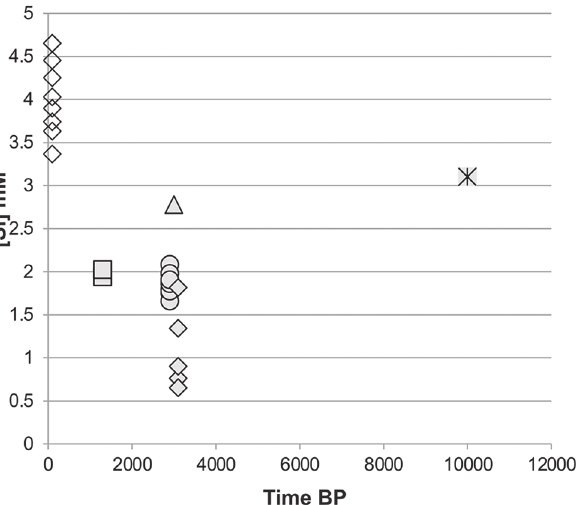
Fig 2. Comparison of solubility at pH 10 among modern and ancient phytolith assemblages in relation to antiquity. Open diamonds: modern plants (this study and wheat from Cabanes et al .[27]). Squares: 7 th century AD assemblages from the shallowly buried site of Wadi el-Mustayer, Negev desert, Israel [40]. Circles: 9 th century BCE assemblages from the deeply buried site of Tell es-Safi/Gath, southern Shephela, Israel. Triangle: 10 th century BCE assemblage from the deeply buried site of Tel Dor, northern coast, Israel [27]. Full diamonds: 11 th century BCE assemblages from the shallowly buried site of Izbet Sartah, western Samarian hills, Israel [37]. Star: 9 th -mid 8 th millennia BCE assemblages from the deeply buried site of A ş ı kl ı Höyük, Anatolia, Turkey. Note that high solubility at pH 10 indicates better preservation as solubility is closer to that of modern plant assemblages. The lowest values, indicating poor preservation, were obtained from shallowly buried sites from humid Mediterranean environments. The highest values, indicating good preservation, were obtained from deeply buried sites in various environmental settings with no relation to antiquity. Exceptional good preservation is noticed in shallowly buried sites in arid environments.